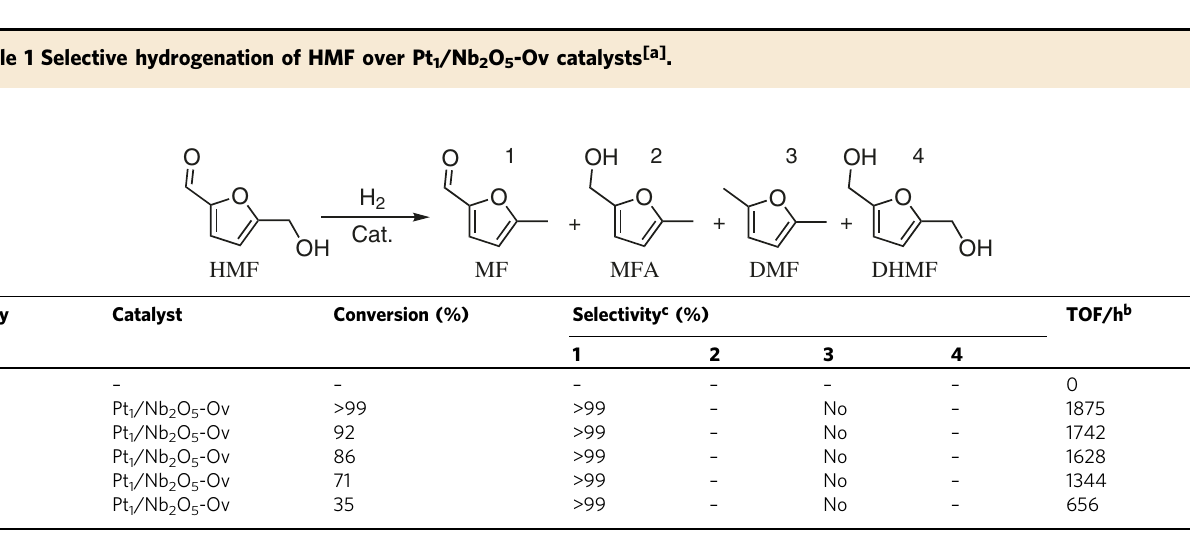
Fig. 3 The electron state characterization of Pt 1 /Nb 2 O 5 -Ov. a The XANES spectra at the Pt L3-edge. b The XPS spectra of Nb 3 d and c O1 s of Pt 1 /Nb 2 O 5 - Ov and Nb 2 O 5